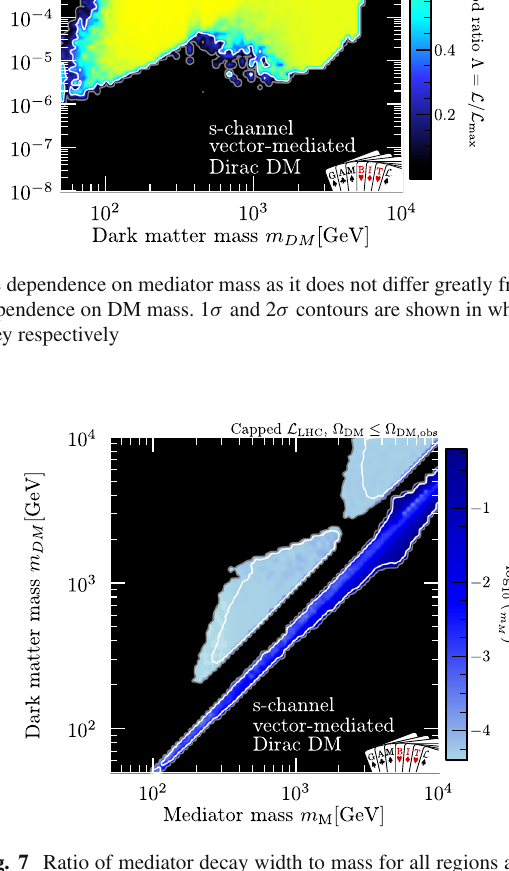
Fig. 7 Ratio of mediator decay width to mass for all regions allowed in Fig.4 (top